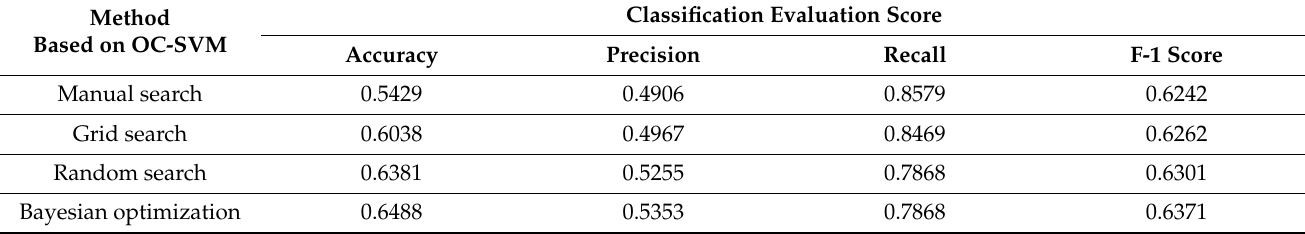
Table 4. Performance results for all